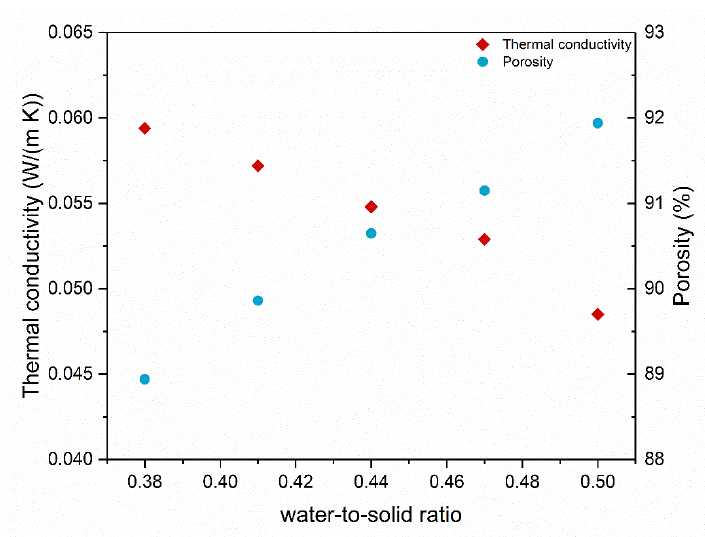
Figure 12. Porosity and thermal conductivity of geopolymers with different water-to-solid ratios according to Reference [86].